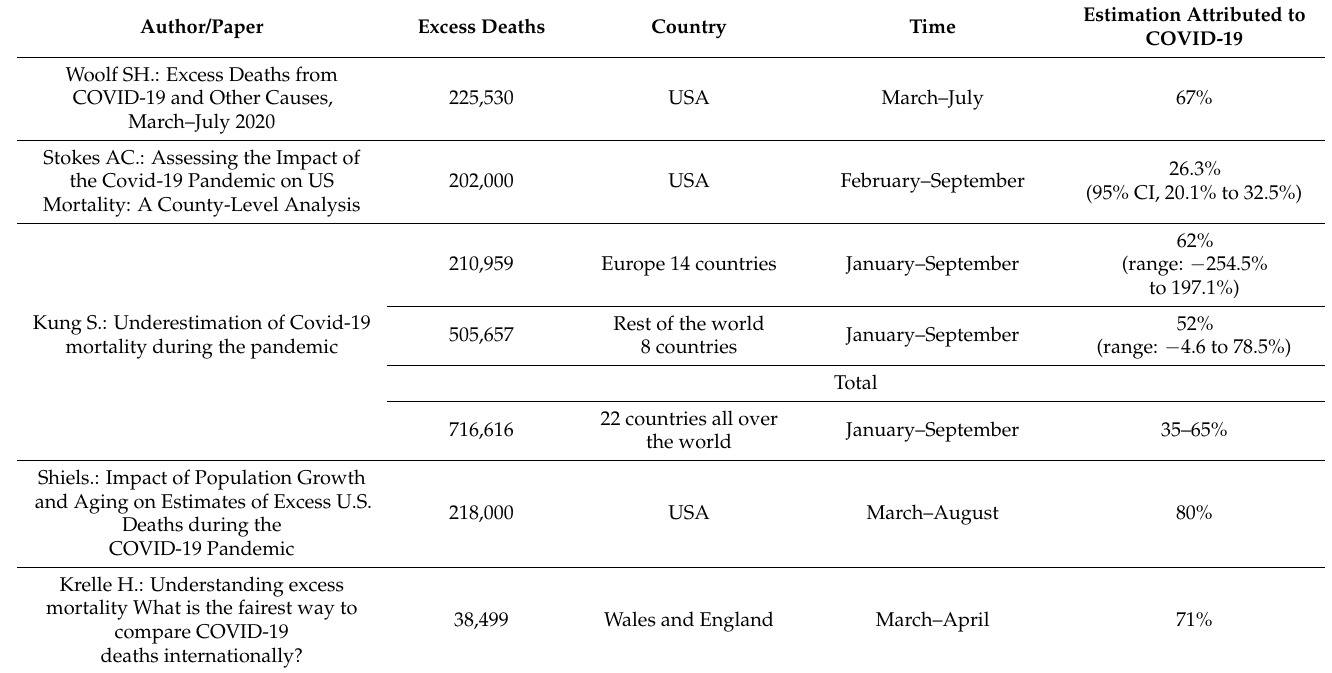
Table 1. Impact of COVID-19 on excess mortality in particular studies